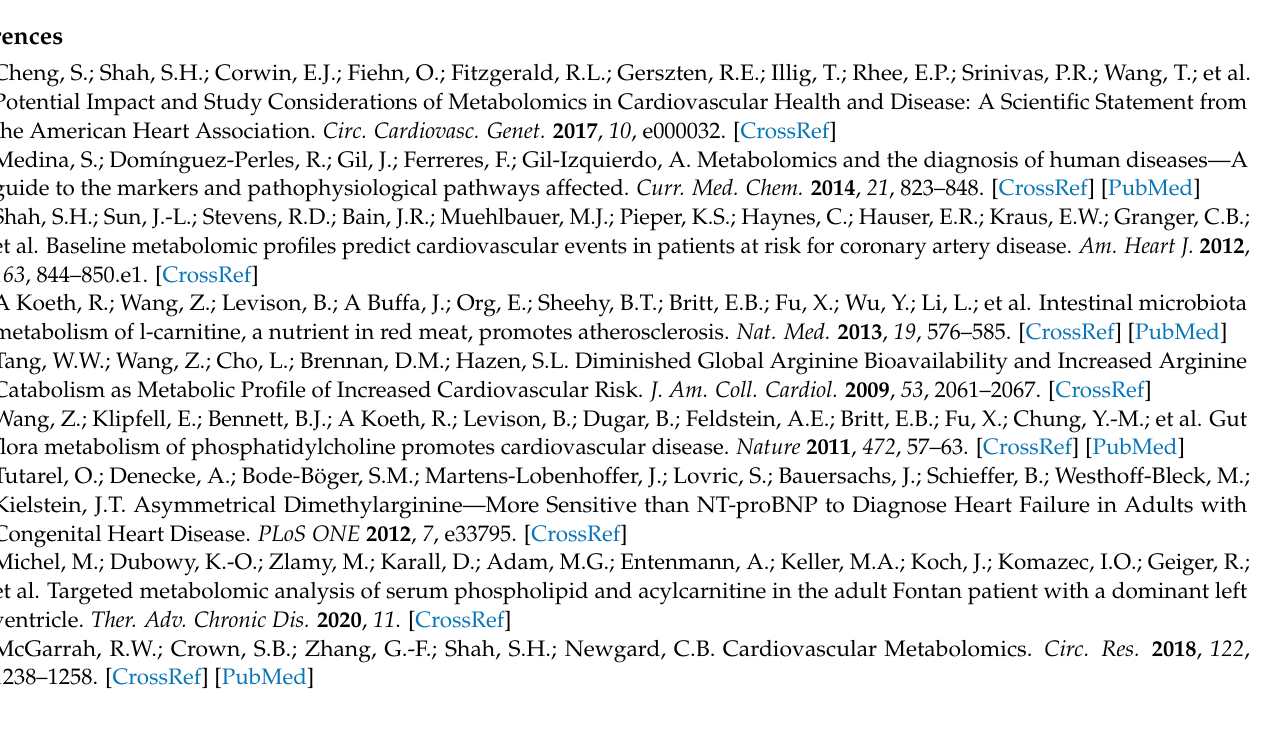
outcomes, Table S2: Patient clinical status at the time of sample collection, Table S3: Non-cardiac diagnoses. Each space includes all non-cardiac diagnoses for each of the 71 patients in whom a non-cardiac diagnosis was present, Table S4: Significantly impacted pathways stratified by diagnoses, Figure S1: Volcano plots for differential expression of metabolites between controls and patients with ACHD, stratified by type of diagnosis, Figure S2: Principal cluster analysis plot in 3 dimensions, Figure S3: Volcano plots for differential expression of metabolites between patients with and without various clinical characteristics and